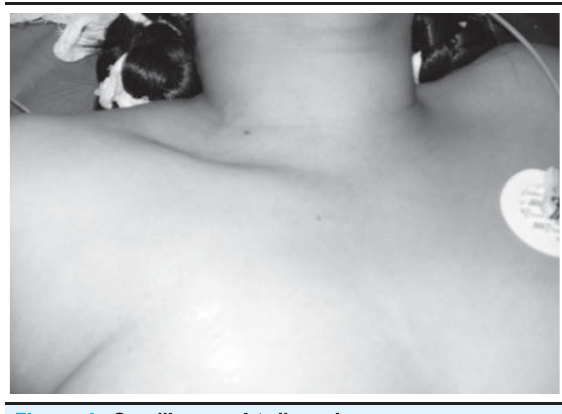
Figure 1. Swelling on 1 st rib region